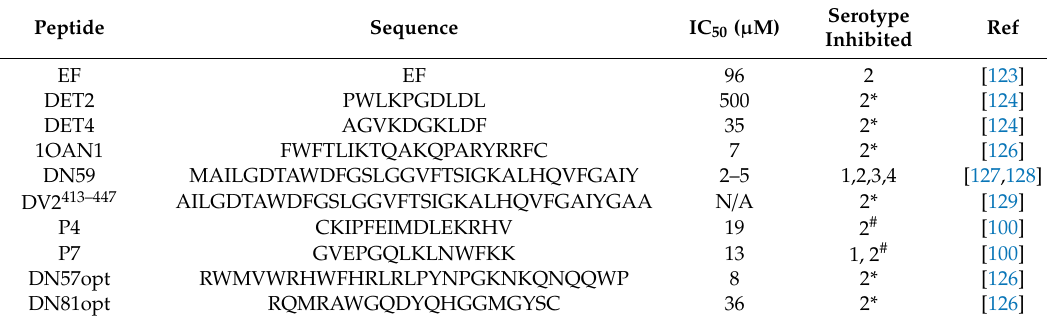
Table 3. Antiviral peptides targeting the E protein or mimicking the action of the E protein. Peptide